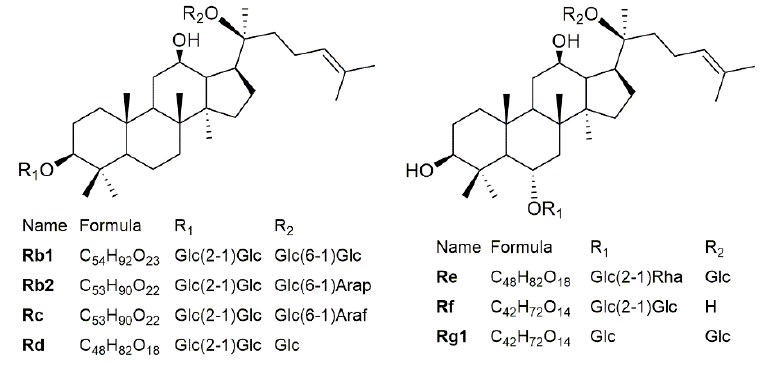
Figure 1. The chemical structures of main ginsenosides. Glc, Arap, Araf, and Rha refer to β -D-glucopyranosyl, α -L-arabinopyranosyl, α -L-arabinofuranosyl, and α -L-rhamnopranosyl, respectively.